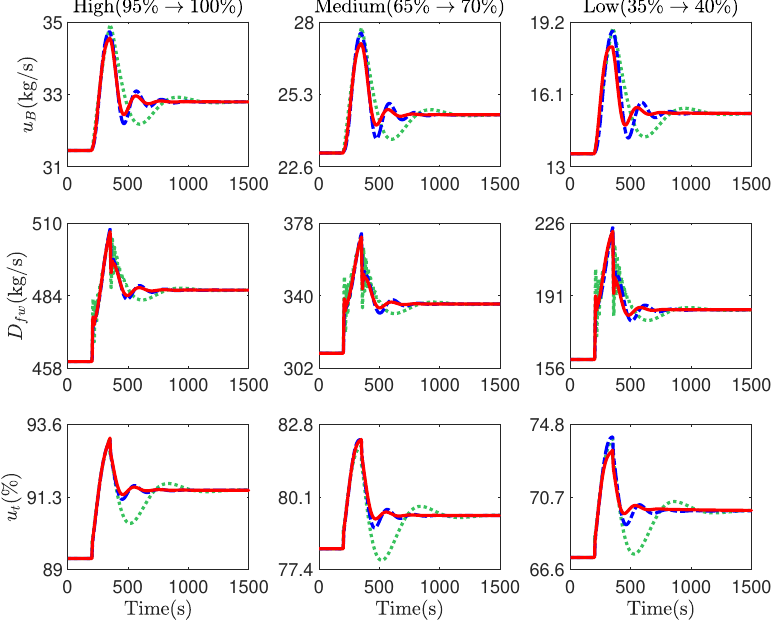
Figure 10. Load following performance of supercritical CFB unit at typical conditions (load increase). The simulation results indicate that all three decentralized control methods can regulate the supercritical CFB unit and make the unit follow the command from grid. When the controllers are well tuned, both the output power N e and separator steam enthalpy h m can closely track the references. The major difference is the control performance in throttle steam pressure P st , and the transient response criteria are listed in Tables 2 and